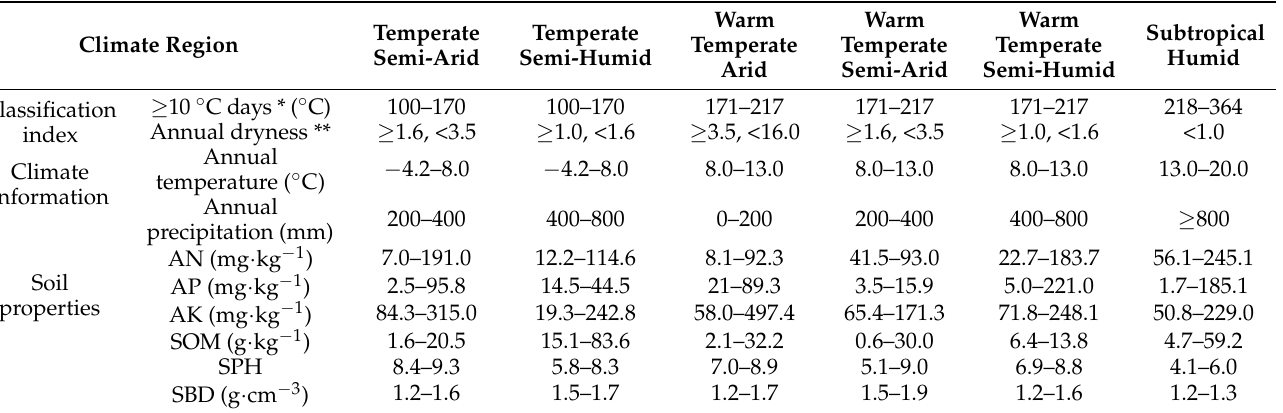
Table 1. Classification standard of climatic regionalization in China and corresponding basic infor- mation of soil and climate in apple cultivation